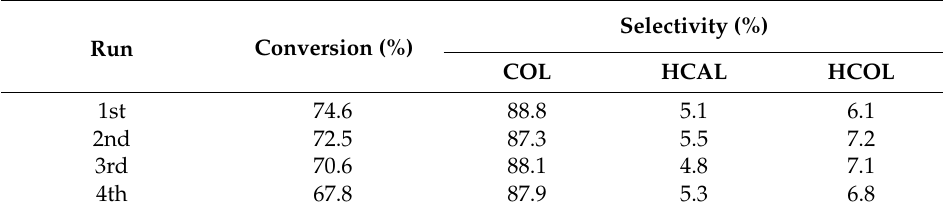
Table 8. Reusability of the Au/Zn 0.7 Fe 0.3 O x catalyst for CAL hydrogenation. Run Conversion (%)